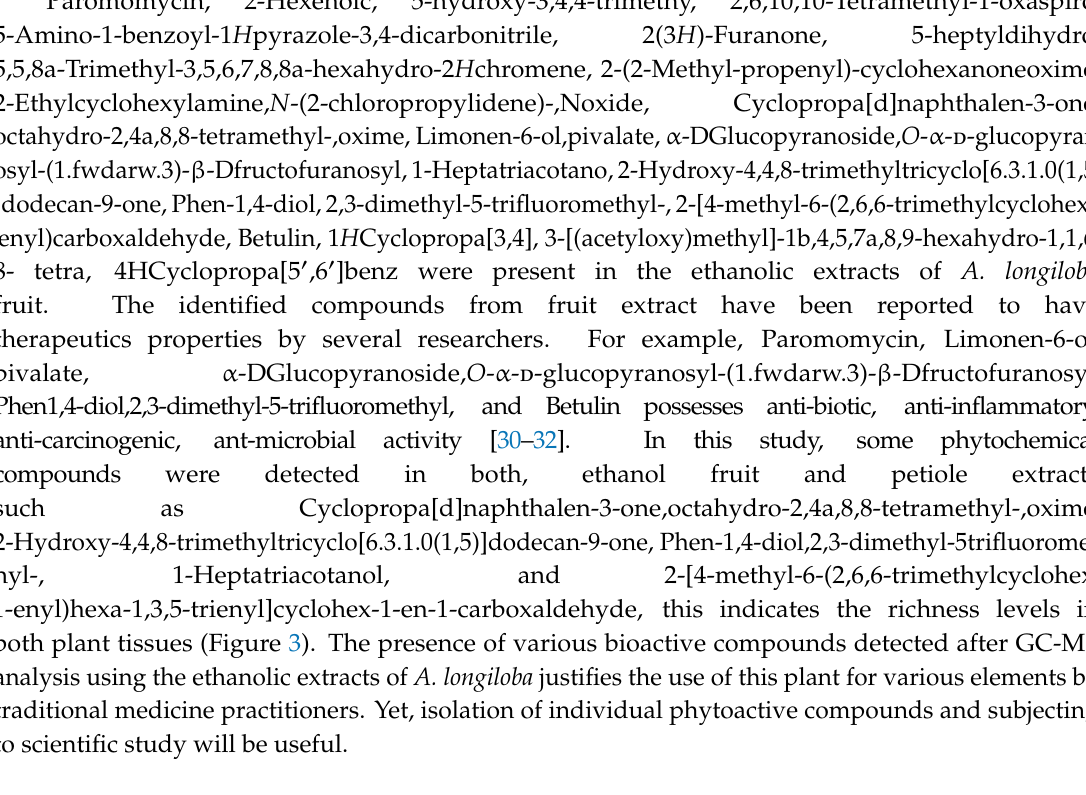
Figure 3. The chemical structures of GC-MS detected compounds in both fruit and petiole. Table 3. List of compounds from ethanolic petiole and fruit extracts observed in GC-MS with their retention time and biological activity.